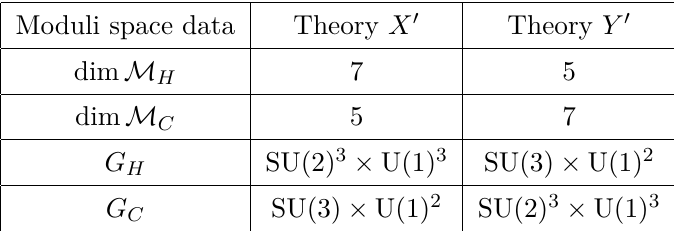
Figure 14 . The quiver X 0 is the 3d mirror of D 9 (SU(3)) reduced on a circle, constructed from a class S prescription. The quiver Y 0 is the 3d mirror of X 0 , i.e. a Lagrangian realization of the SCFT obtained by the reduction of D (SU(3)) on a circle. 9